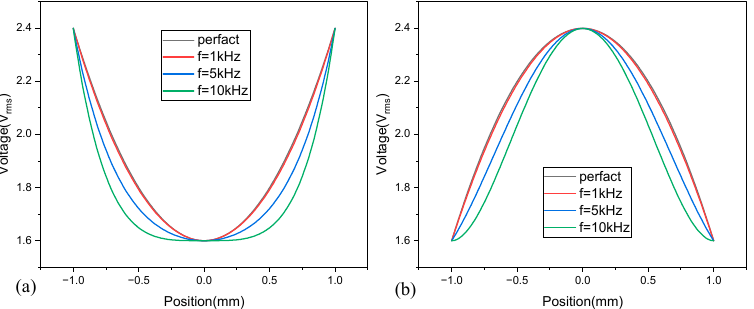
Figure 7. The radial voltage distributions under different frequencies. ( a ) Positive LC lens V 1 = 1.6 V rms V 2 = 2.4 V rms . ( b ) Negative LC lens V 1 = 2.4 V rms V 2 = 1.6 V rms . V 1 = 1.6 V rms , V 2 = 2.4 V rms . ( b ) Negative LC lens V 1 = 2.4 V rms , V 2 = 1.6 V rms